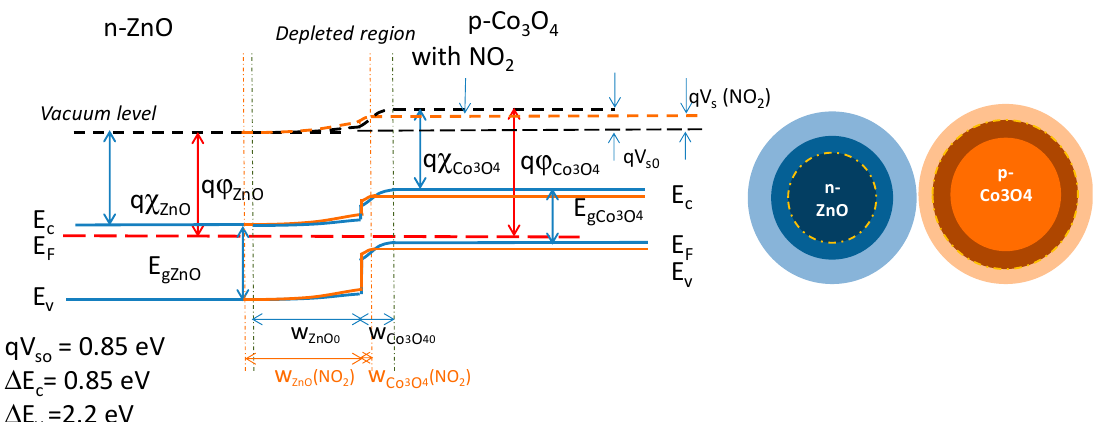
Figure 7. Formation of the heterojunction and behavior with an oxidizing gas.